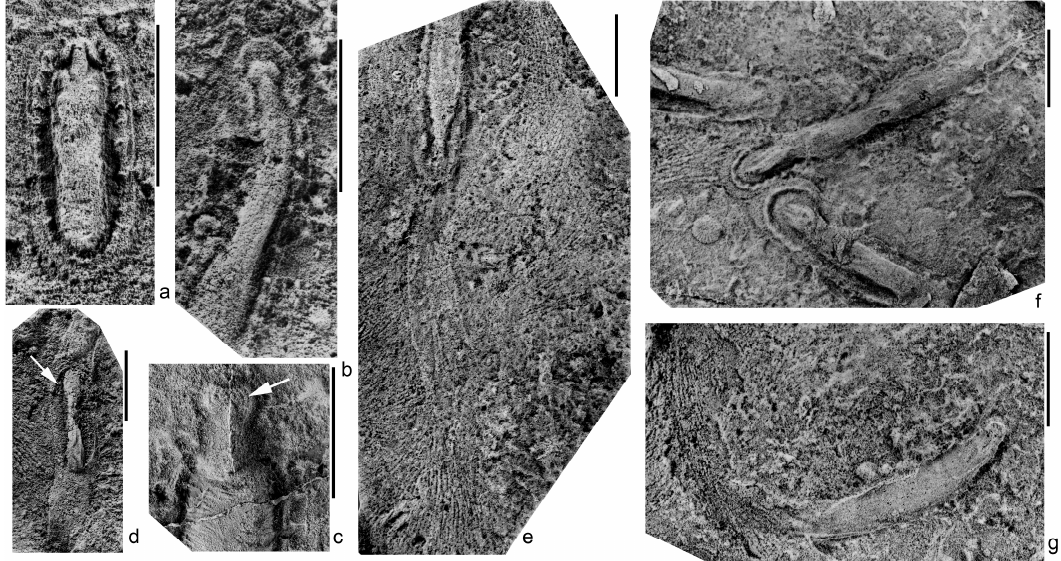
Figure 1. Kimberella quadrata (Glaessner et Wade, 1966), a common preservation variant in which the sclerites of the dorsal integuments were dissolved; southeastern White Sea region, ( a , b , d – g )—Solza locality, burial SL1(VII), ( c )—Zimnie Gory locality, burial Z1(I) “Kimberella lenses”; latex casts from natural imprints; scale bars are 1 cm: ( a – c )—isolated bodies ( a )—specimen with retracted head section, spec. PIN, no. 4853 / 314; ( b )—the specimen of approximately the same body width as in Figure 1a, but with maximum elongated head section, spec. PIN, no. 4853 / 336; ( c )—head section with an assumed tooth battery (arrow), spec. PIN, no. 3993 / 9200); ( d – g )—traces of locomotion, presumably, bands of mucus reinforced with aleuro-clayey material, surrounded by grooves, representing feeding traces of Kimberella ( Kimberichnus ) ( d )—spec. PIN, no. 4853 / 366, the body (marked with an arrow) is located in the middle of the mucus band; ( e )—thin weakly visible band extended to the oral end of the stretched specimen, spec. PIN, no. 4853 / 320; ( f )—three specimens, crawled into one place from di ff erent sides, the foot of the individual (at the bottom of the image) is deformed as a result of a collision with another individual, spec. PIN, no. 4853 / 10-12; ( g )—single slightly curved band, the body of a trace producer is absent (perhaps the organism had moved from the bedding plane into the overlying sediment), spec. PIN, no. 4853 / 316).